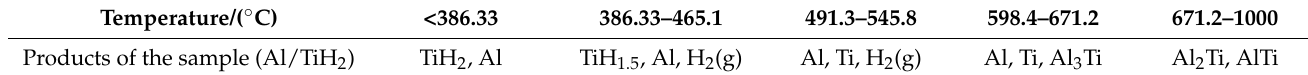
Table 14. Products of samples (Al/TiH 2 ) at different temperatures.